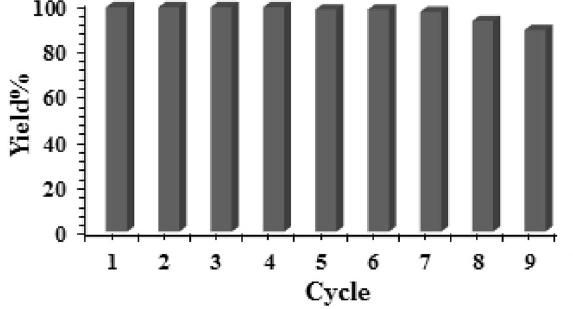
Figure 9. The recycling of the UiO-66-biguanidine/Pd nanocomposite.